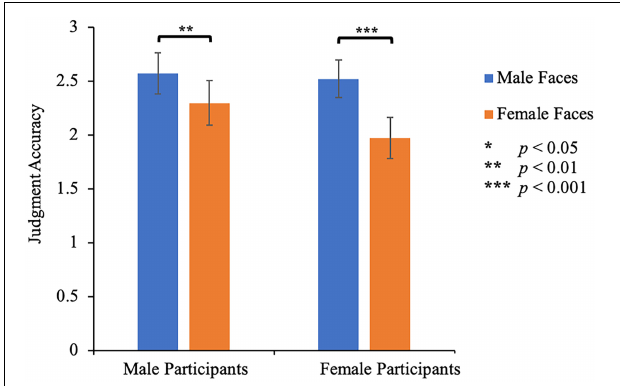
FIGURE 2 | Rating accuracy of facial attractiveness in Study 1. Standardized rating scores as a subtraction of self-rating and other-rating facial attractiveness in Study 1. Error bars represent 1 S.E. of the means.